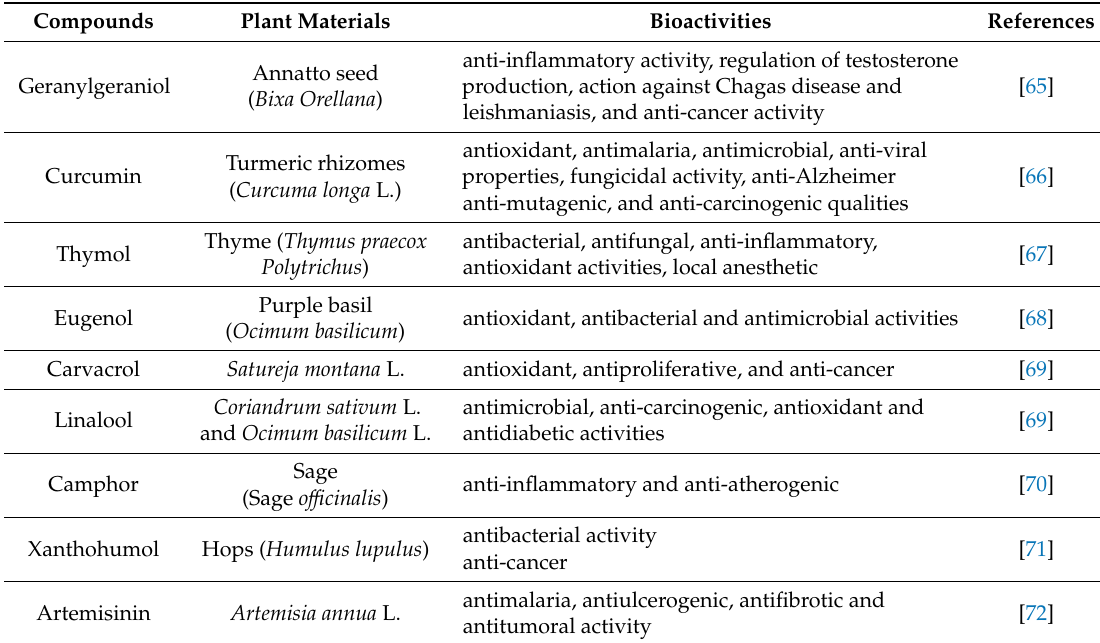
Table 3. Selected bioactive compounds and their